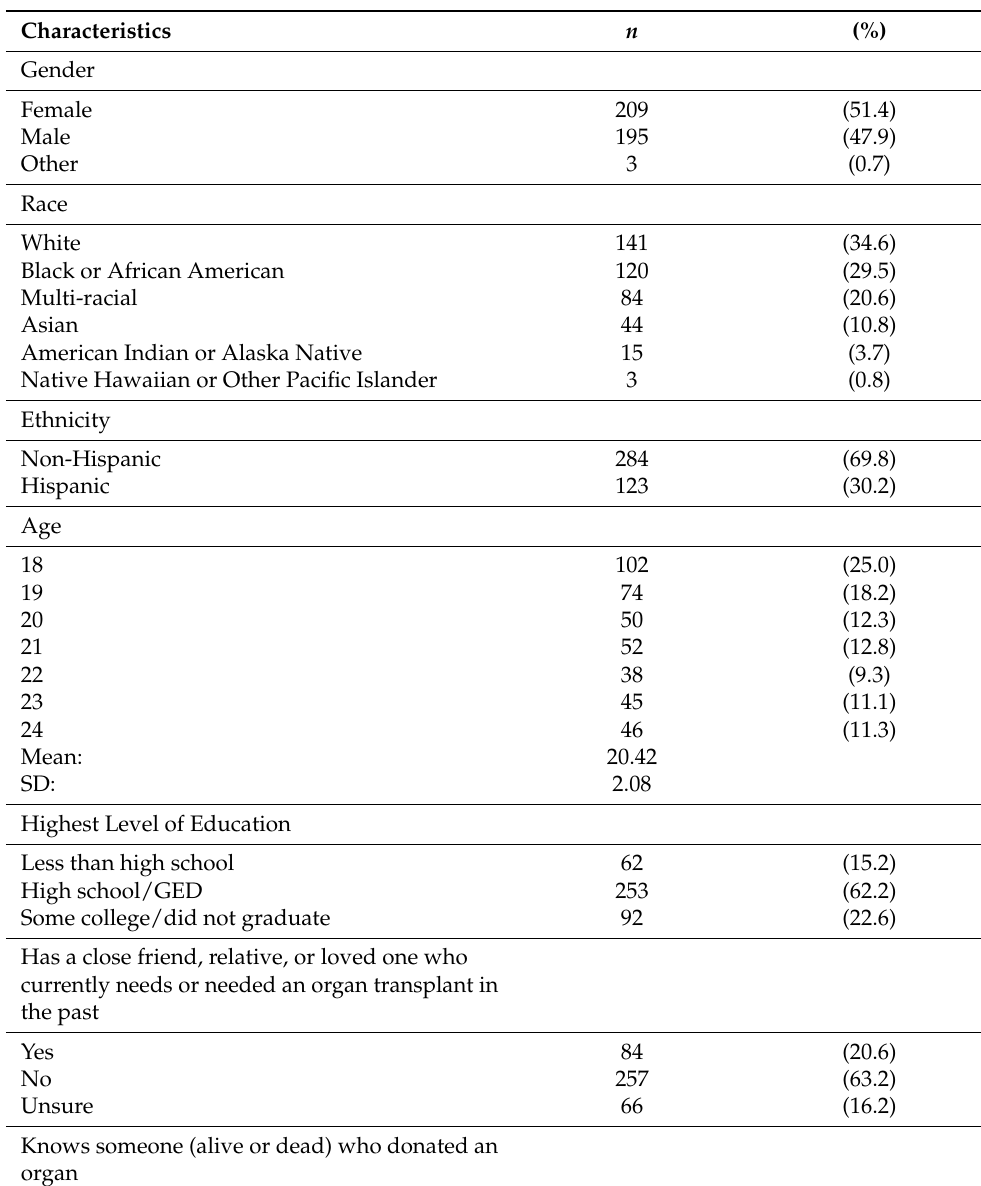
Table 2. Demographics and Background Characteristics of All Survey